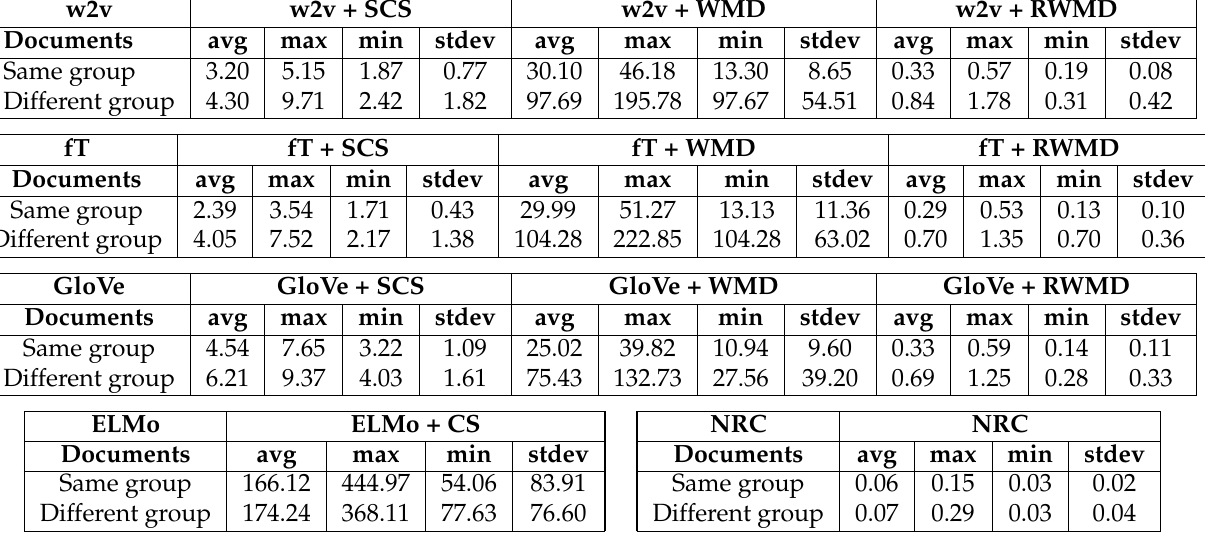
Table 4. Time performance (in seconds) of the different similarity measures when evaluating papers belonging to the same (third row of each table) research group and different ones (fourth row) with the different strategies. The timings include the calculation of the embeddings when necessary and the similarity measurement.